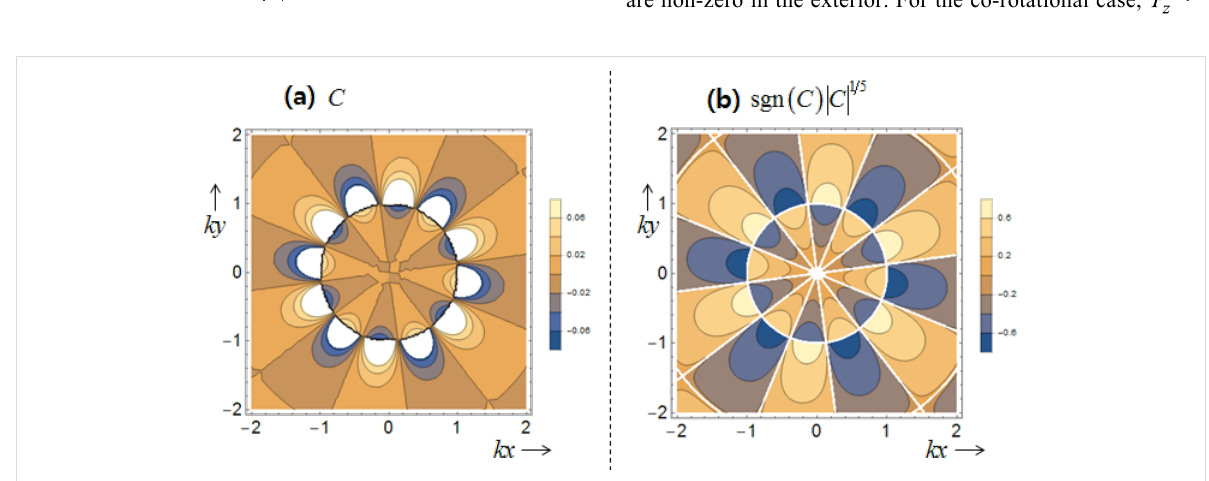
Figure 3: (a) A contour plot of the optical chirality C . (b) A contour plot of the scaled optical chirality sgn( C )| C | 1/5 . Both are plotted in the ( kx , ky )-plane for the counter-rotational case. The data are R ρ ≡ kR = 1, m = 3, and q = i . We have used the commercial software Mathematica ® for drawing these figures so that both negative and positive saturated values are forced to take on the same white color in panel (a). However, one can easily identify the corresponding proper signs from panel